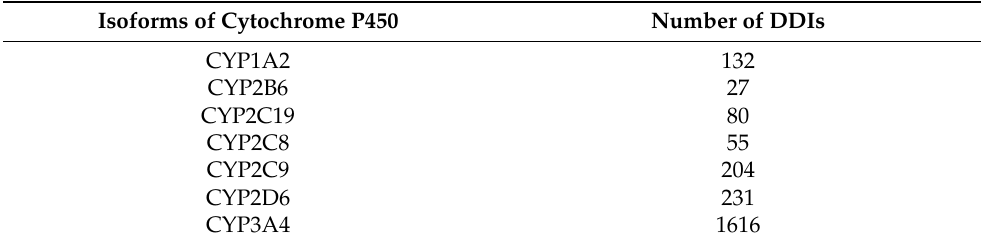
Table 1. The number of drug–drug interactions (DDIs) mediated by various isoforms of cytochrome P450 in the training set. Isoforms of Cytochrome